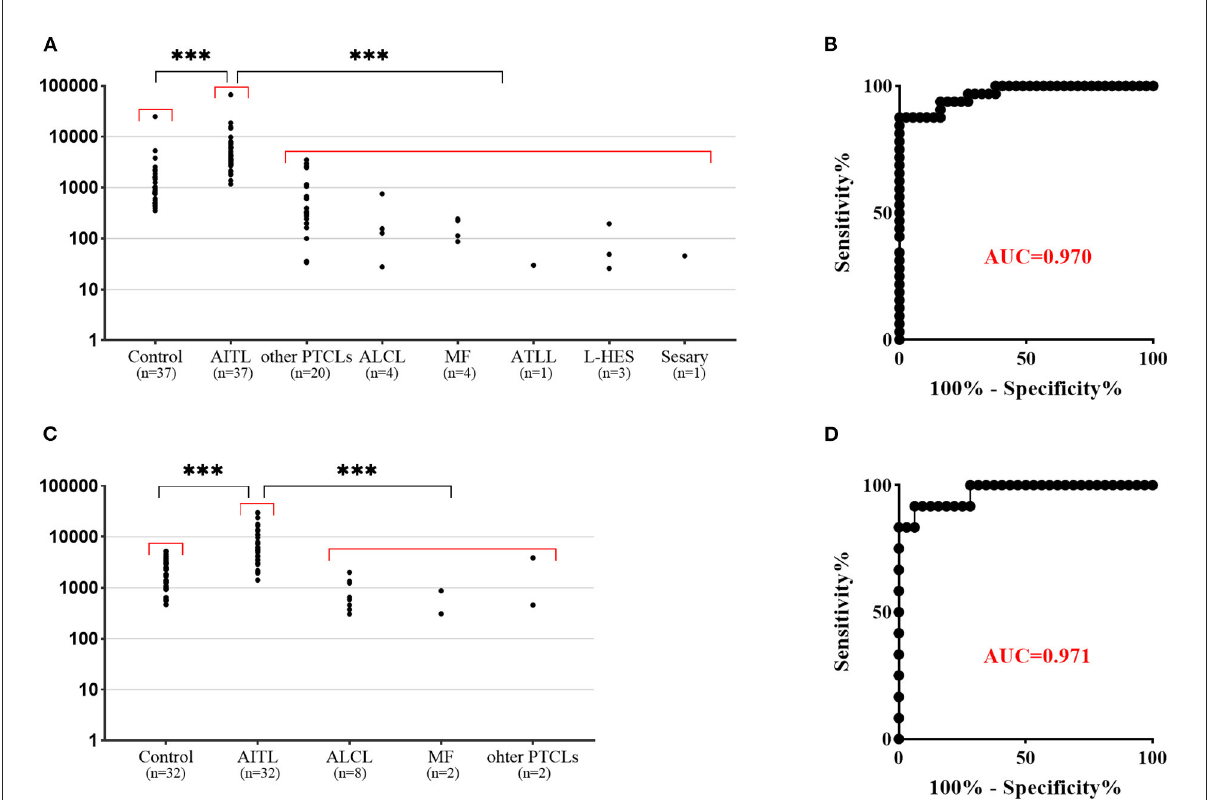
FIGURE3 Flow cytometric findings of PD-1 expression in non-neoplastic CD4 + T cells and T-cell lymphoma. (A) PD-1 mean fluorescent intensity (MFI) in bone marrow samples. The corresponding non-neoplastic CD4 + T cells in AITL were used as a control. The PD-1 MFI in AITL is significantly higher than that in control T cells and other T-cell lymphomas. (B) ROC curve of PD-1 MFI bone marrow samples shows high sensitivity and specificity in differentiating AITL from non-AITL T-cell lymphoma ( p < 0.001, AUC 0.970: sensitivity 100.0% and specificity 83.33% for a cutoff of MFI 1162). (C) PD-1 mean fluorescent intensity (MFI) in tissue samples. The PD-1 MFI in AITL is significantly higher than that in control T cells and other T-cell lymphomas. (D) ROC curve of PD-1 MFI tissue samples shows high sensitivity and specificity in differentiating AITL from non-AITL T-cell lymphoma ( p < 0.001, AUC 0.971: sensitivity 91.67% and specificity 93.75% for a cutoff of MFI 2023). *** p <